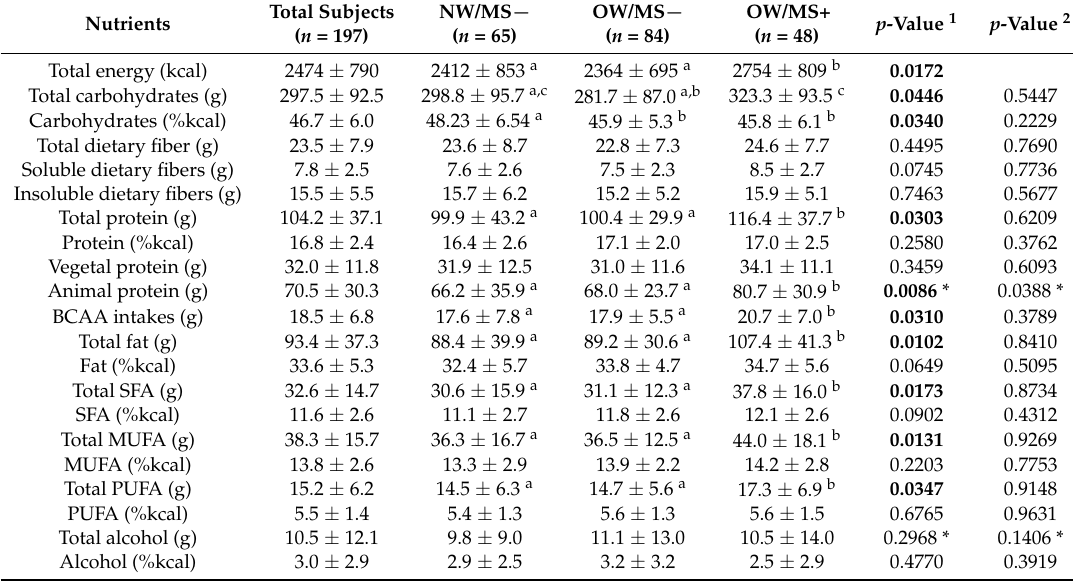
Table 2. Daily dietary energy and macronutrients intakes of